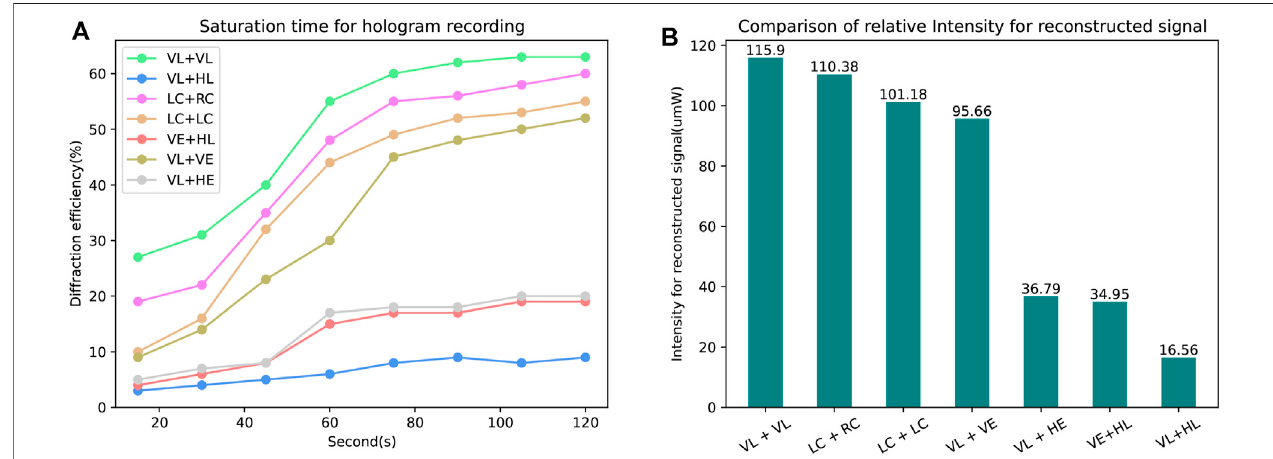
FIGURE3| Resultsforreconstructedholographicimagefromdifferentpolarization. (A) Saturationtimeforhologramrecording, (B) Comparisonofrelativeintensity for reconstructed signal.